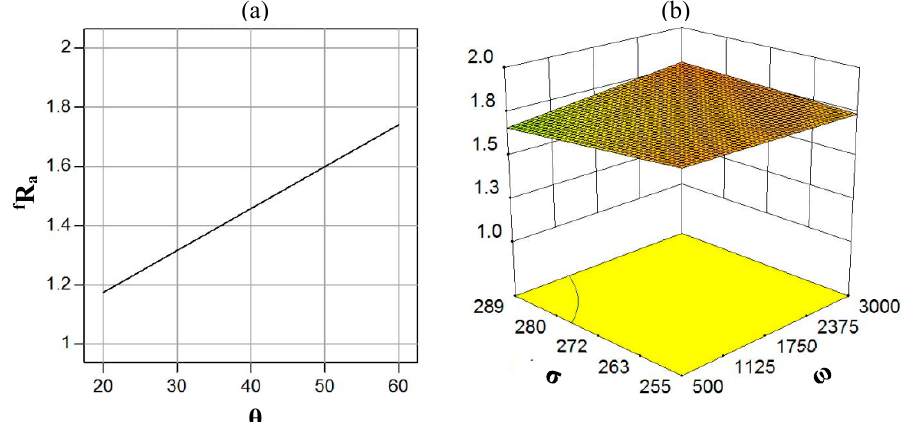
Figure 11. Correlation between the free-surface roughness and process parameters: ( a ) Forming angle, and ( b ) Combined tensile stress and spindle rotation.